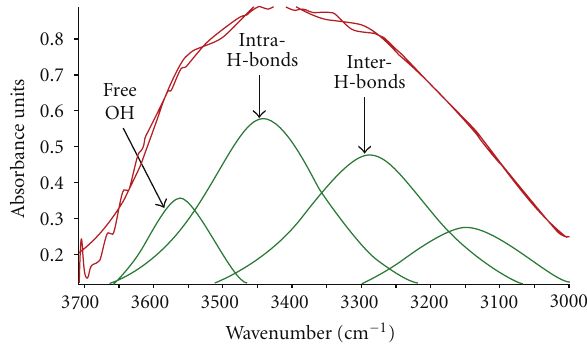
Figure 4: Curve fitting and peak assignments for OH stretching regions: S4: untreated wood